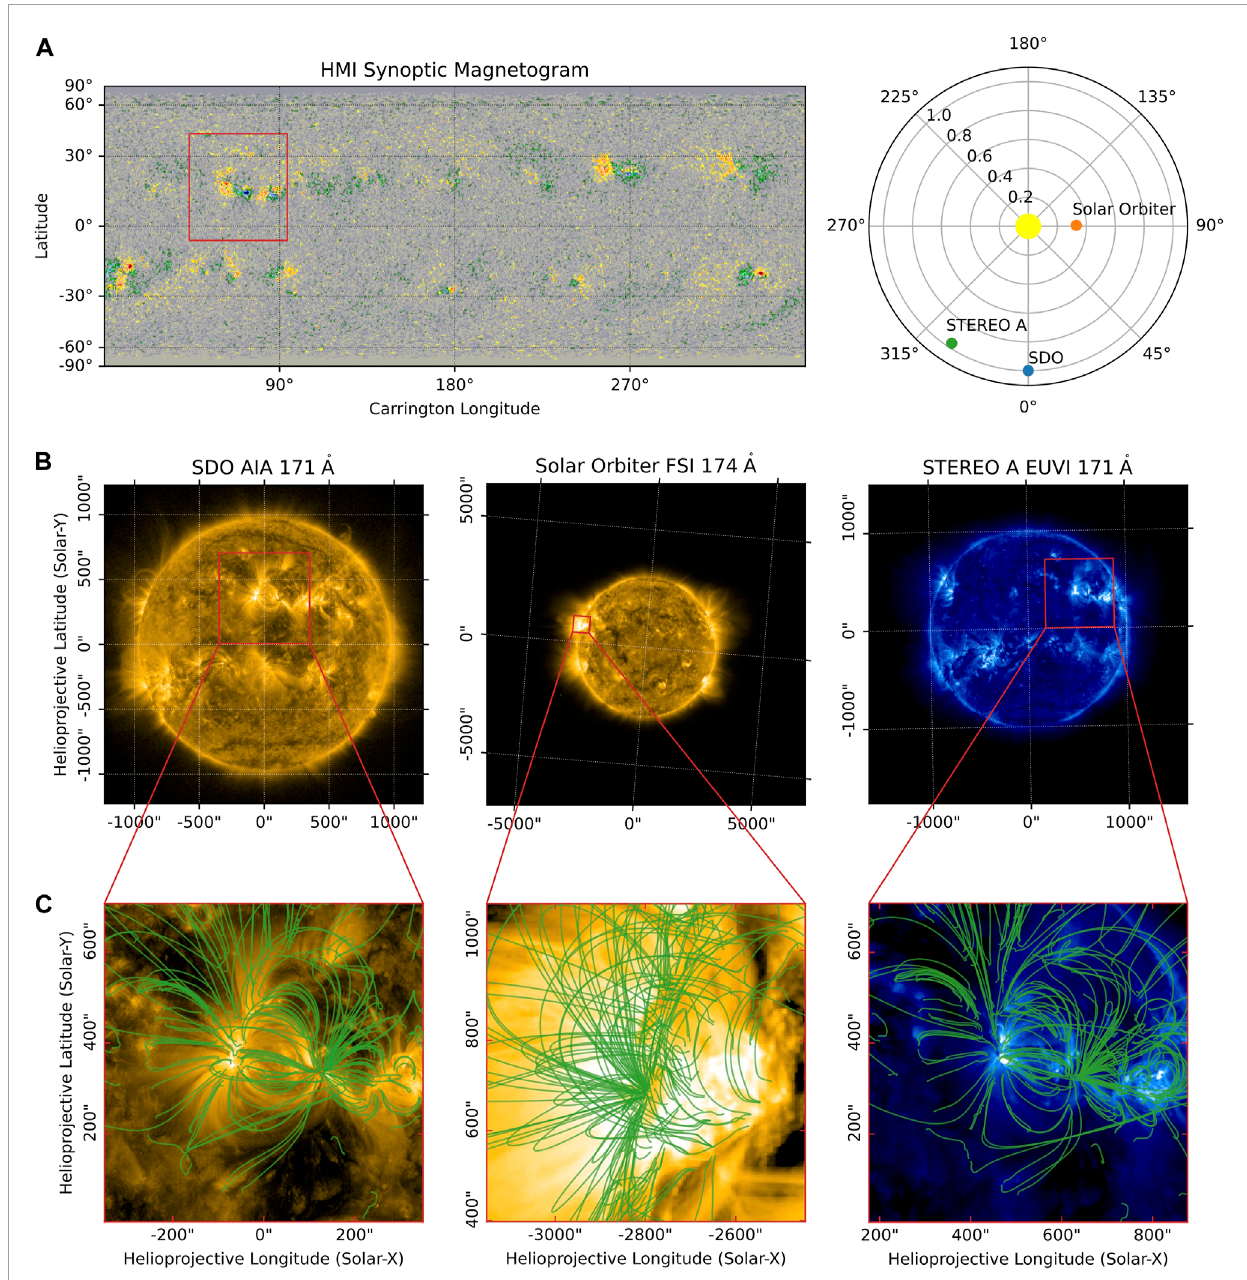
FIGURE 1 Illustration of multiple affiliated packages, including sunpy , sunpy_soar , aiapy, and pfsspy , working together. (A) The left panel shows the HMI synoptic magnetogram for Carrington rotation 2255. The red box is centered on the active region. The right panel shows the Stonyhurst heliographic longitude and radius (in AU) for SDO, STEREO A, and Solar Orbiter on 2022-03-29. (B) Full disk images from SDO AIA at 171 Å (left), SolO FSI at 174 Å (middle), and STEREO-A EUVI at 171 Å (right). All three images were downloaded using sunpy along with sunpy_soar to query the SOAR for the Solar Orbiter image. The AIA image was calibrated using aiapy . The red box in each panel is centered on the AR shown in the top panel. (C) Cutouts of the regions denoted in each image in (B) . pfsspy is used to compute a potential magnetic field solution from the magnetogram in (A) and trace field lines through the resulting volume. These field lines, shown in green, are transformed to the appropriate coordinate system of each instrument using sunpy .